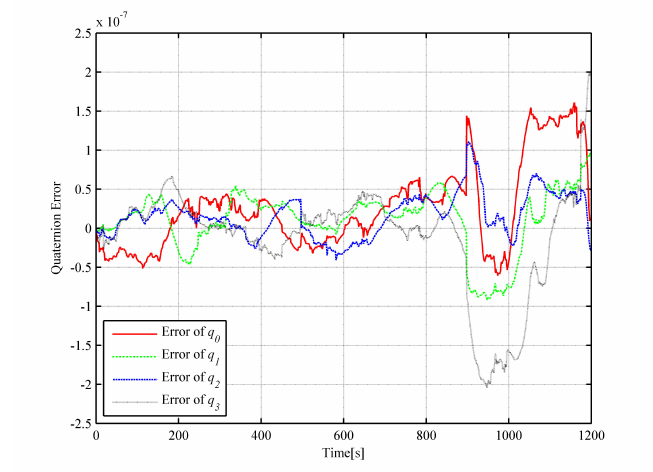
Figure 5. Curve of the quaternion error (based on the inverse